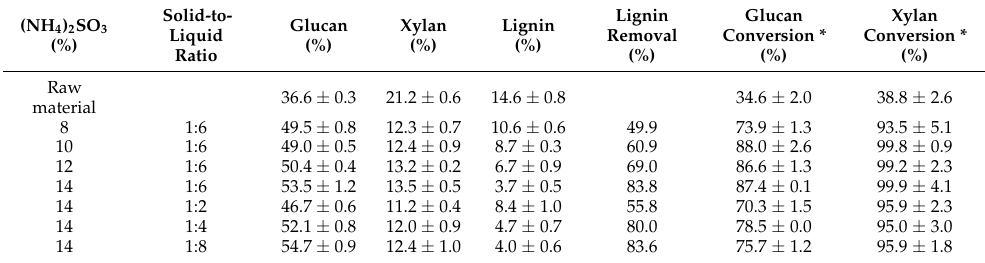
Table 2. Changes in chemical compositions and conversions of glucan and xylan in pretreated corn stover before and after AS pretreatment under different